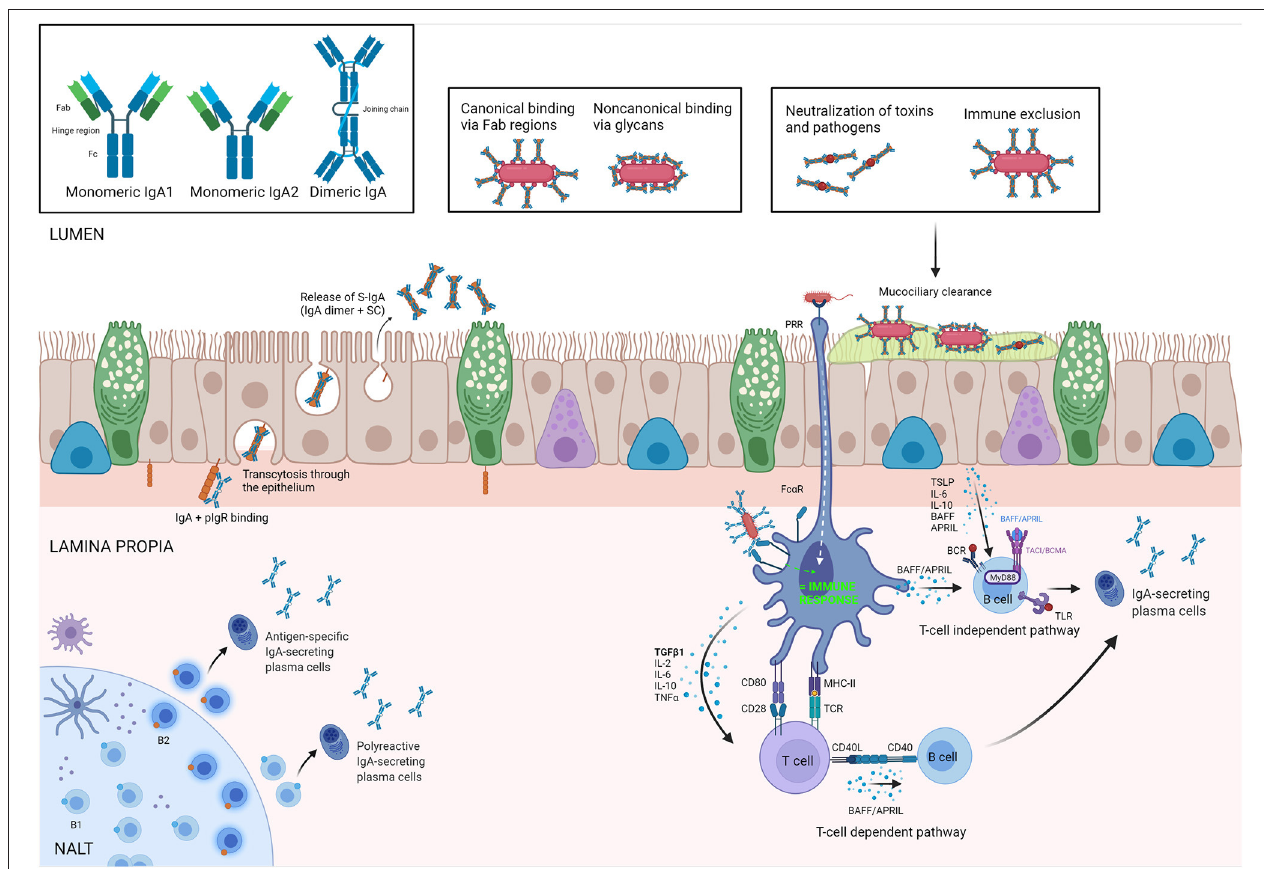
FIGURE 1 | IgA biology. Isoforms of IgA are illustrated in upper-left square. In the Nasal Asocciated Lymphoid Tissue (NALT), antigen-specific and polyreactive IgA is produced by B2 and B1 cells, respectively, and secreted in the lamina propria by plasma cells as dimeric IgA (dIgA). The polymeric immunoglobulin receptor (pIgR) is responsible for its transepithelial transport toward the lumen, where dIgA is released bound to the secretory component (SC). The complex IgA/SC is what we know as secretory IgA (S-IgA). In the lumen, S-IgA binds toxins and allergens in either a canonical and/or non-canonical way to perform its main roles: neutralization and immune exclusion, preventing bacterial colonization by invasive species (panel inserts). Antigen-activated T-cells induce an IgA class switch in B-cells, typically in the presence of Transforming Growth Factor beta (TGF- β ), or other mediators secreted by dendritic cells (DC) or epithelium. T-cell independent IgA class switch occurs either via direct antigenic activation of B-cells or via production of B cell activation factor (BAFF) and/or A proliferation inducing ligand (APRIL) by DCs. TSLP, thymic stromal lymphopoietin; PRR, pattern-recognition receptor; TLR, toll like receptor; TACI, transmembrane activator and calcium modulating cyclophilin ligand interactor. Created with